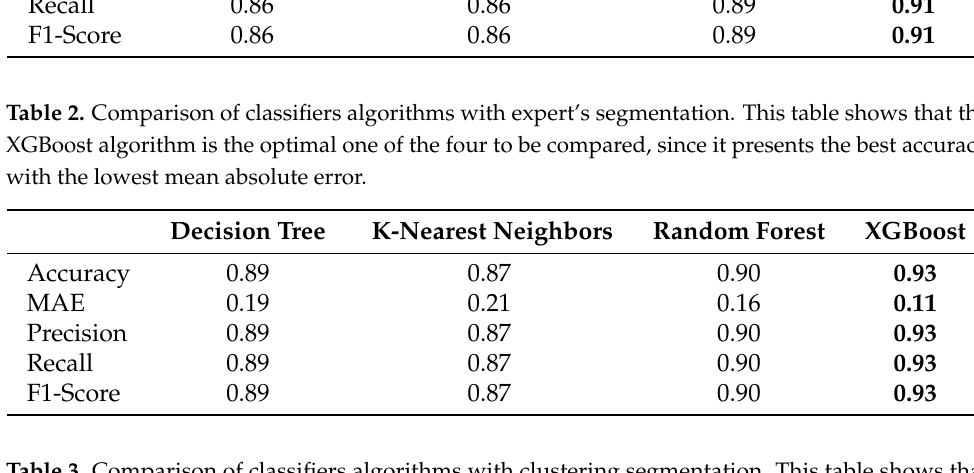
Table 3. Comparison of classifiers algorithms with clustering segmentation. This table shows that both the XGBoost and KNN algorithms can be the most optimal of the four to be compared, given that they present the best accuracy, with the lowest mean absolute